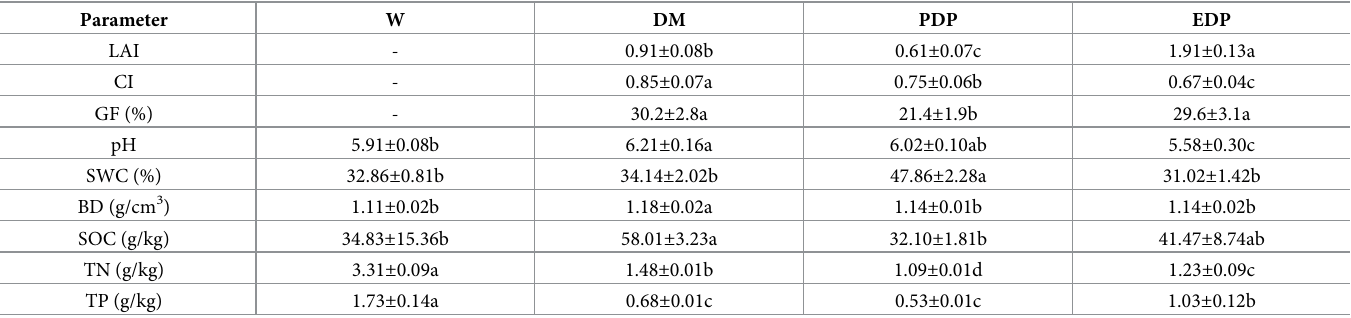
Means and standard deviations of leaf area index (LAI), clumping index (CI), gap fraction (GF), pH, soil water concentration (SWC), bulk density (BD), soil organic carbon concentration (SOC), total nitrogen (TN) and total phosphorus (TP). Different lowercase letters denote a significant difference among the different vegetation types at p <